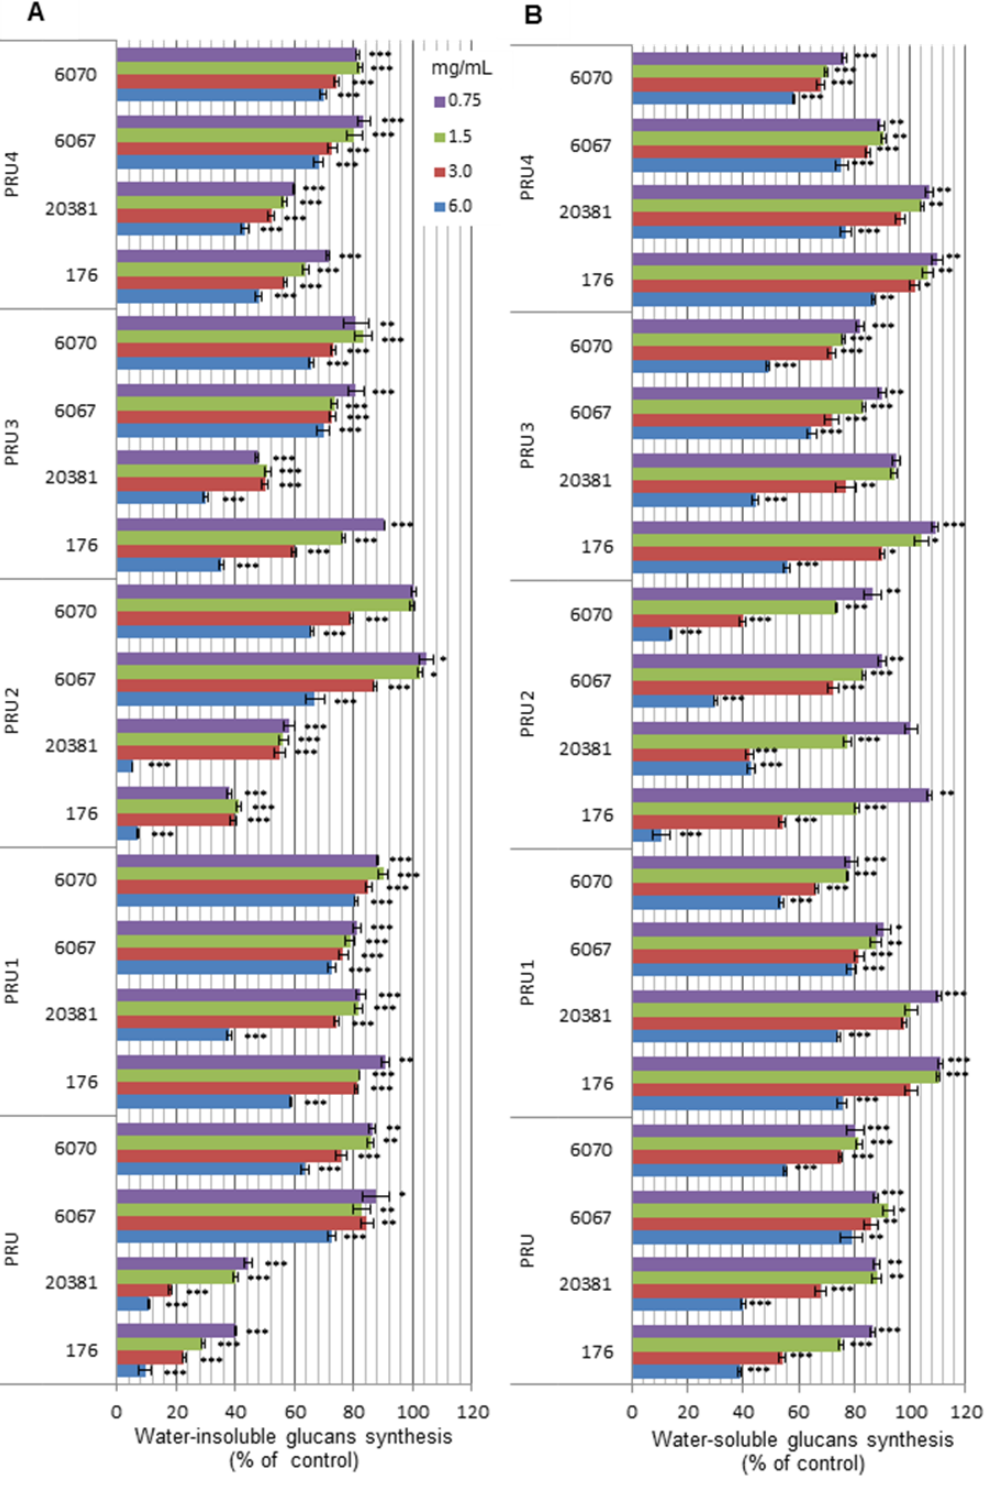
Figure 3. Inhibitory effects of D. rupestris preparations on water-insoluble ( A ) and water-soluble ( B ) glucan synthesis by glucosyltransferases of mutans streptococci. Results